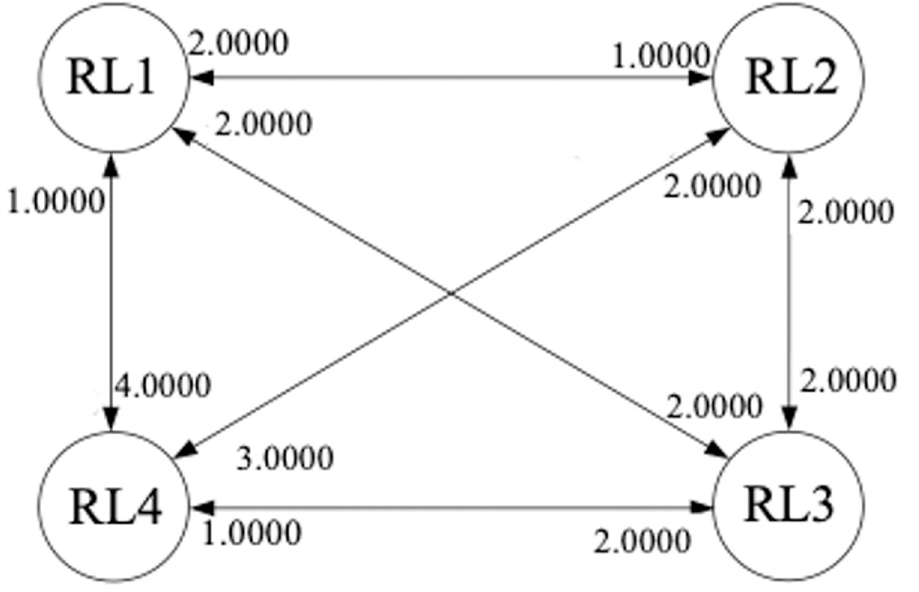
Fig 4. The direct-influential matrix for the RL